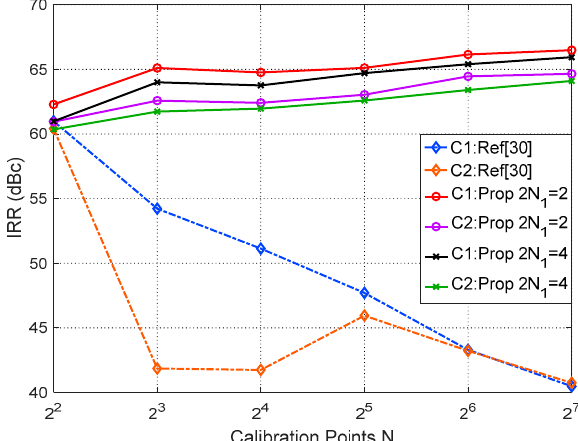
Figure 9. Spectral IRR performance of the I / Q mismatch Cases (C1 / C2) with the di ff erent number of calibration points and signal points.